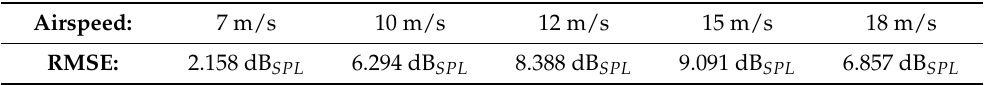
Table 1. Overall RMSE between the PSDs of the left-mounted microphone data segments from the wind tunnel experiments (motor configuration D and AoA of 0 ◦ ) and the PSDs predicted by the Robertson model under the same conditions for every airspeed